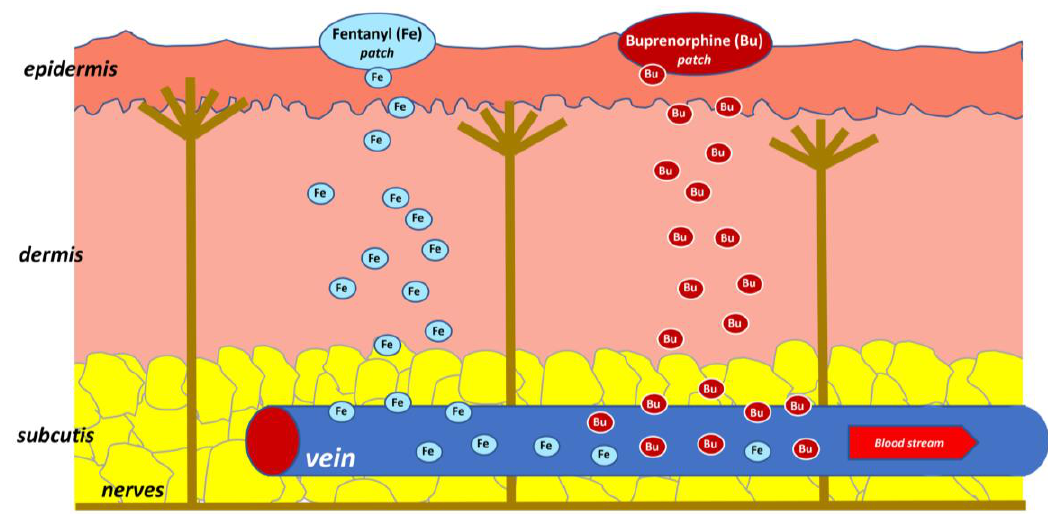
Figure 1. Transdermal application for systemically acting drugs.